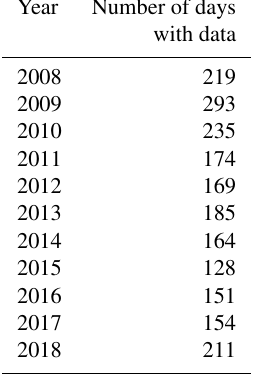
Table 1. Distribution of number of days with